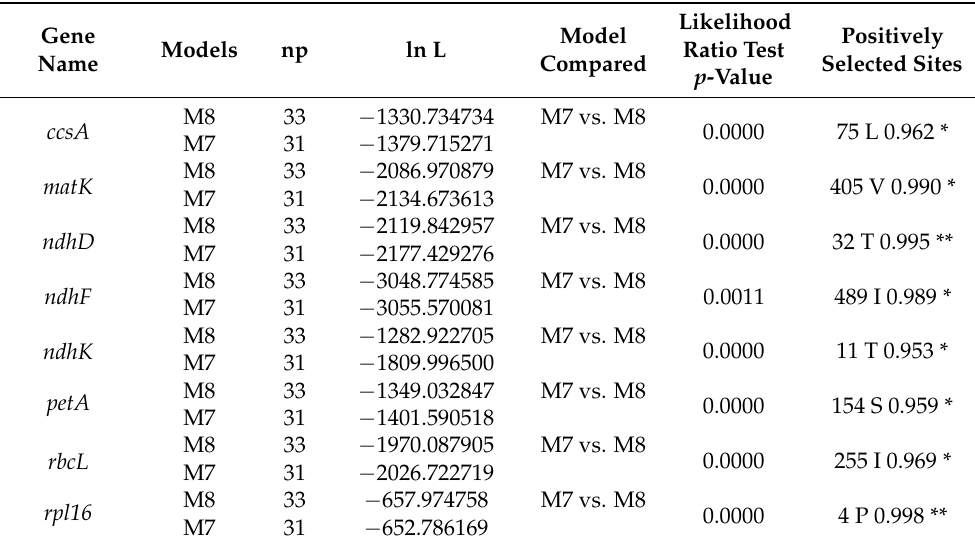
Table 2. Log-Likelihood values of site-specific models, with detected sites having dN/dS values > 1.